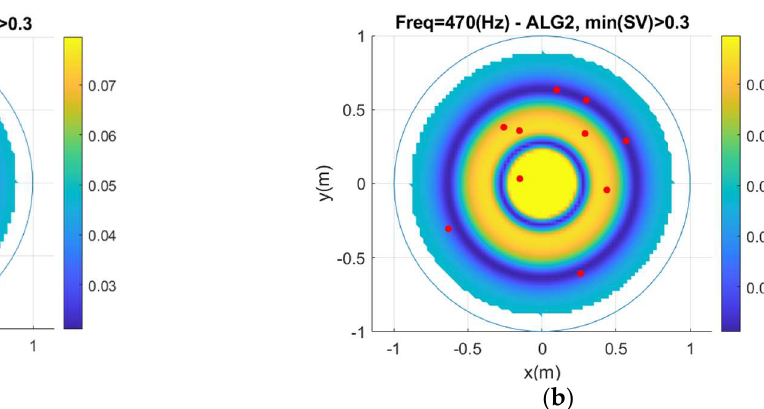
Figure 10. Final position of the CHIEF points after the optimization procedure considering min (SV)